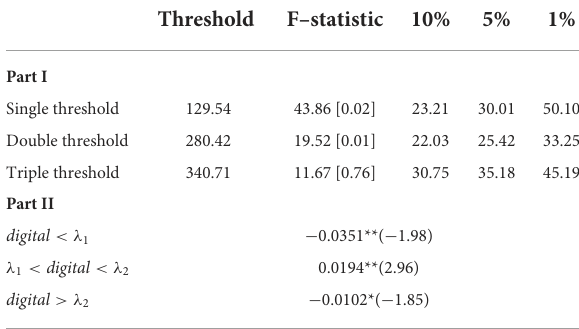
TABLE 5 Threshold effect test and threshold estimation